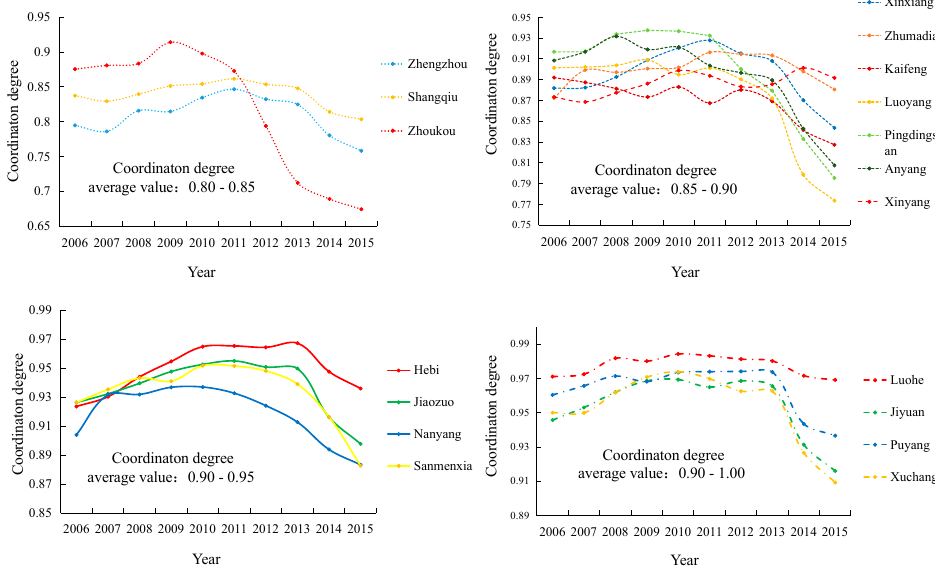
Figure 7. Evaluation of economic development coordination degrees in Henan Province from 2006 to 2015.